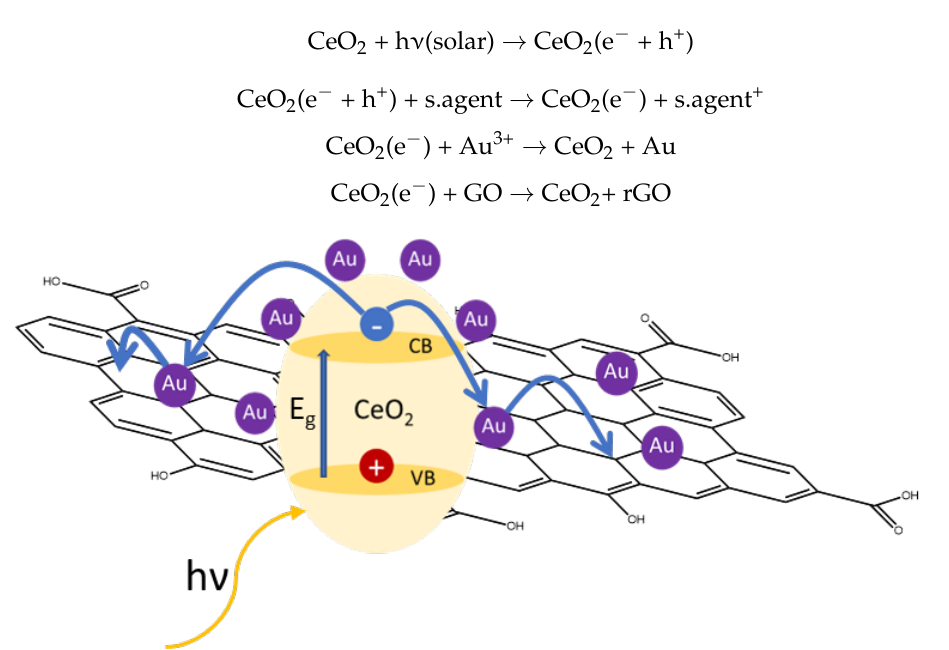
Figure 8. Representative scheme of the interactions in the sample CeO 2 -rGO-Au.